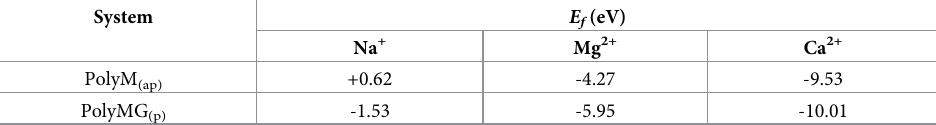
Table 3. Formation energies (eV) for the cation cross-linked PolyM (ap) and PolyMG (p)